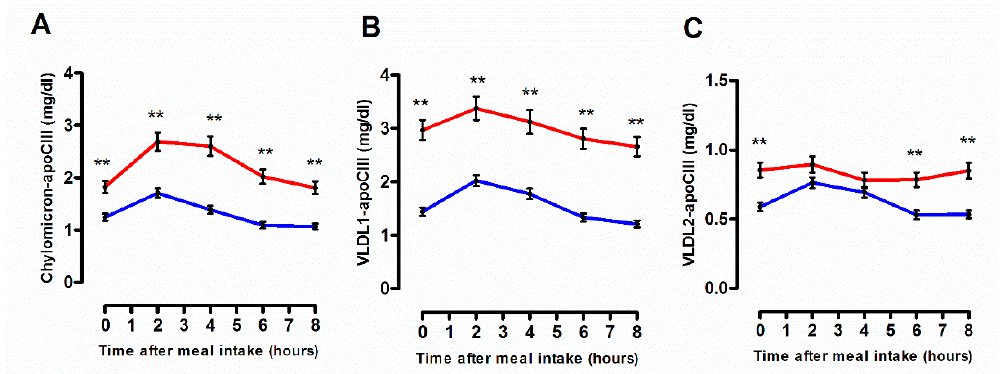
Figure 3. Postprandial plasma levels of chylomicron-apoCIII (A), large VLDL1-apoCIII (B) and small VLDL2-apoCIII (C) from G Low (blue curve) and G High (red curve). Values are mean ± SEM. ** p < 0.001 versus G Low.